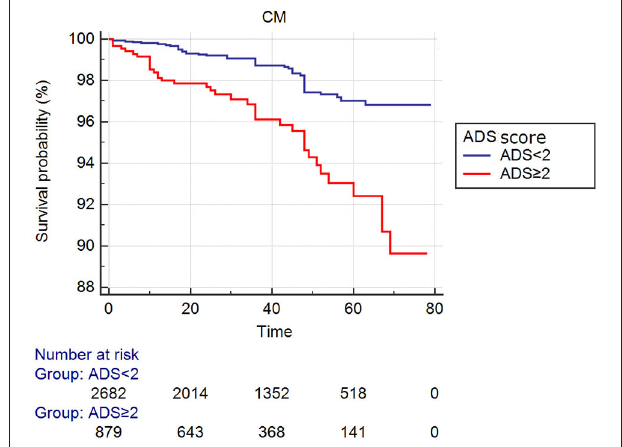
FIGURE 2 | Cumulative Kaplan–Meier estimates of the time to the first adjudicated occurrence of primary endpoints (ACM).